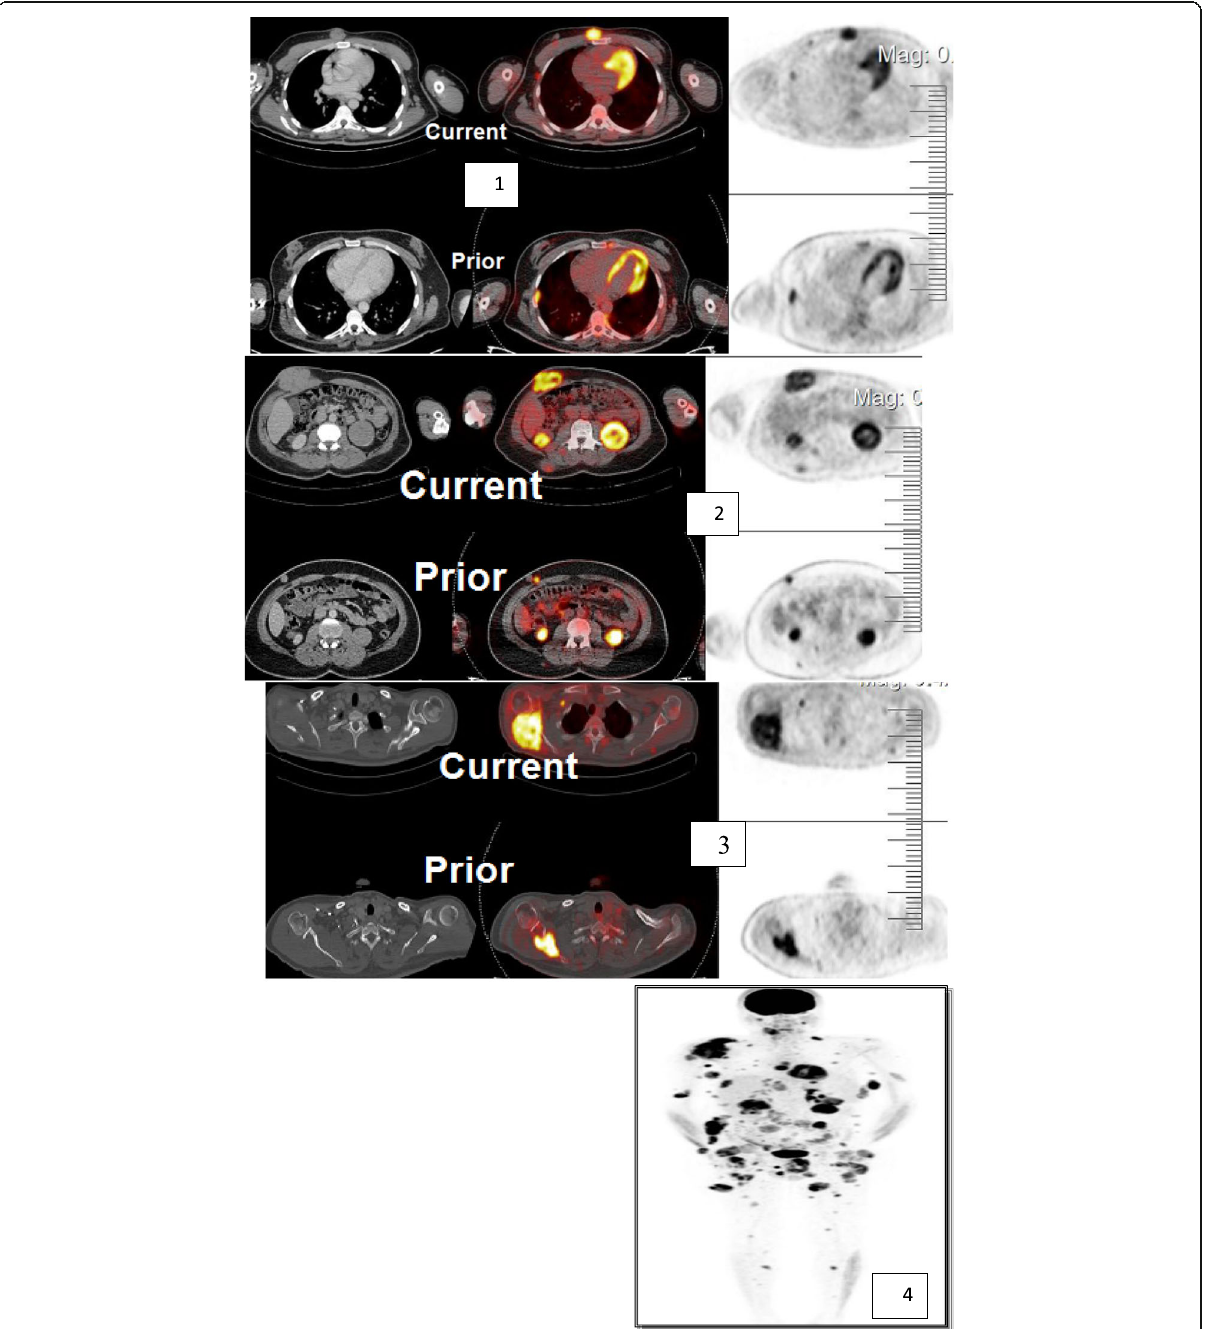
Fig. 4 1 Axial CT, PET, and PET/CT images showing newly developed FDG avid anterior chest wall lesion. Metabolic and morphologic progression of the lesion seen in the left postro-lateral lower chest wall. 2 Axial CT, PET, and PET/CT images showing progression in size of anterior abdominal wall lesion. 3 Axial CT, PET, and PET/CT images showing progression in size of right scapular lesion. 4 PET image showing peritoneal, hepatic, nodal, bone, and skin metastatic